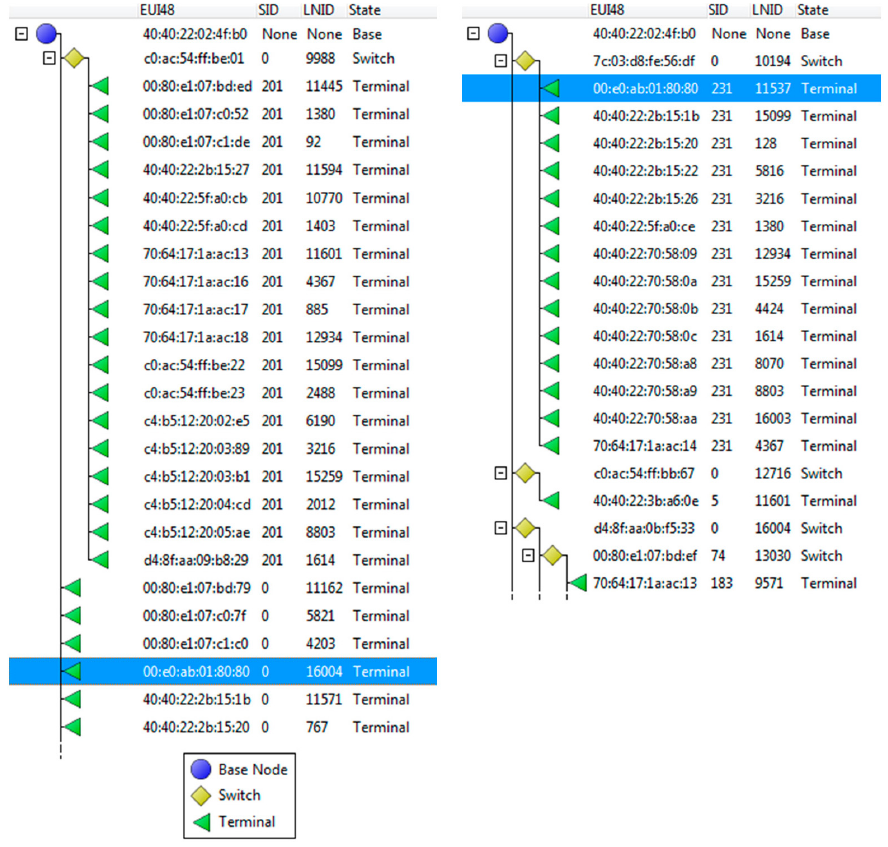
Figure 6. Topologies (first level on the left and second level on the right) for switching environment tests.